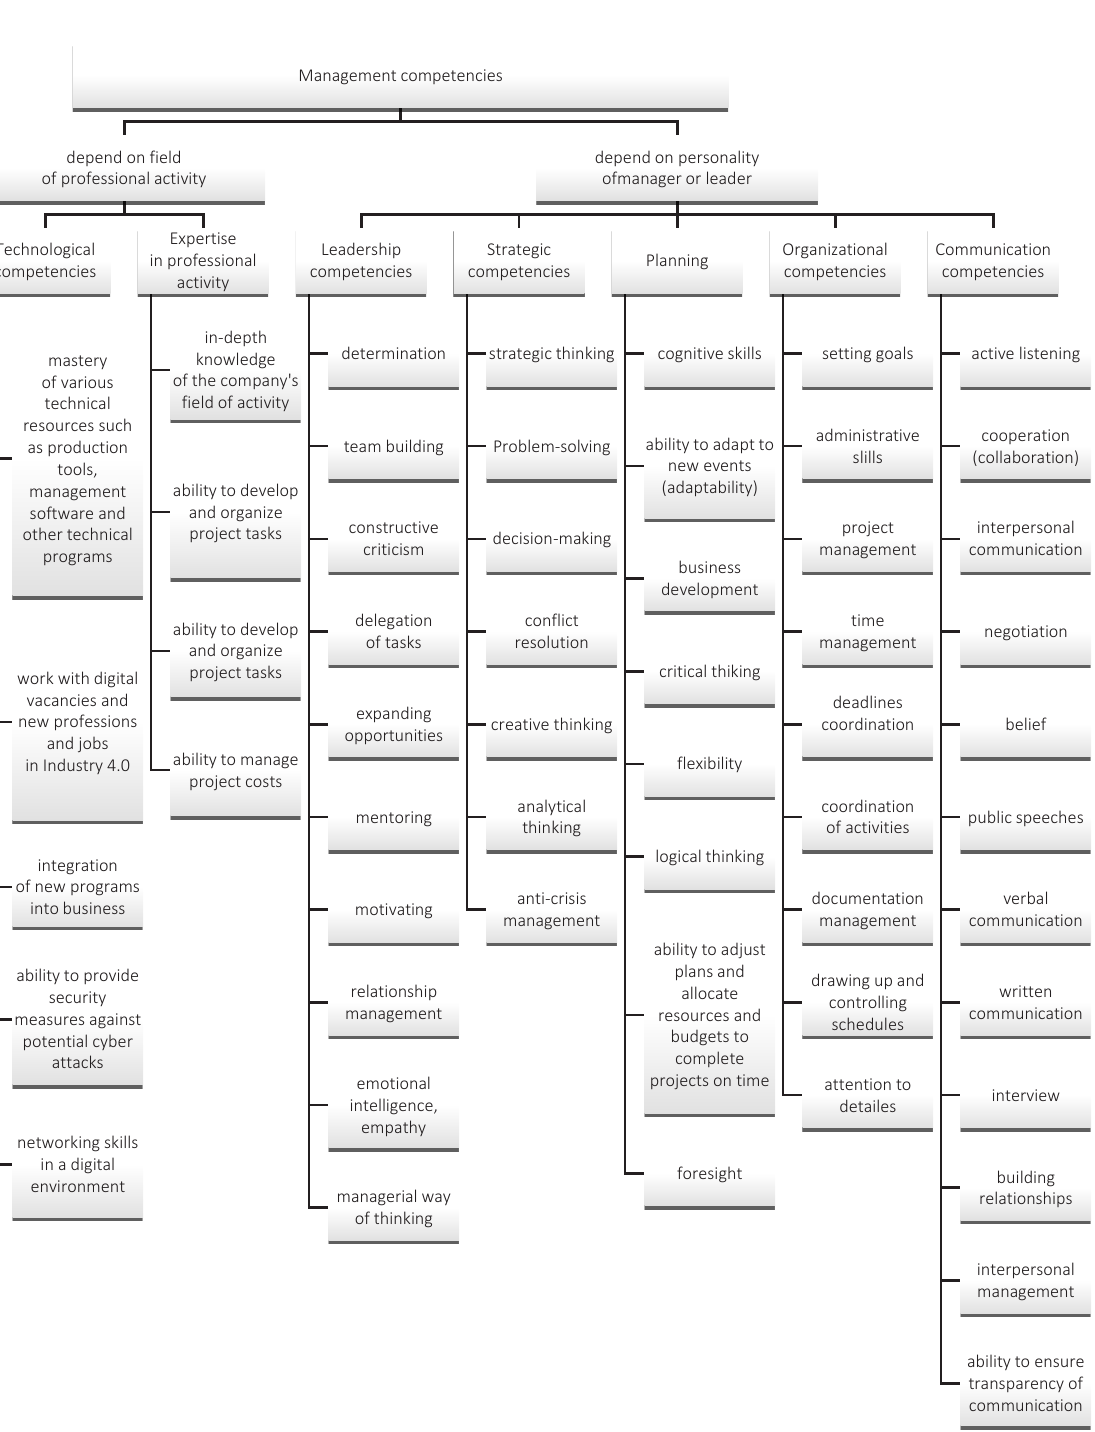
Figure 1. Classification of managerial